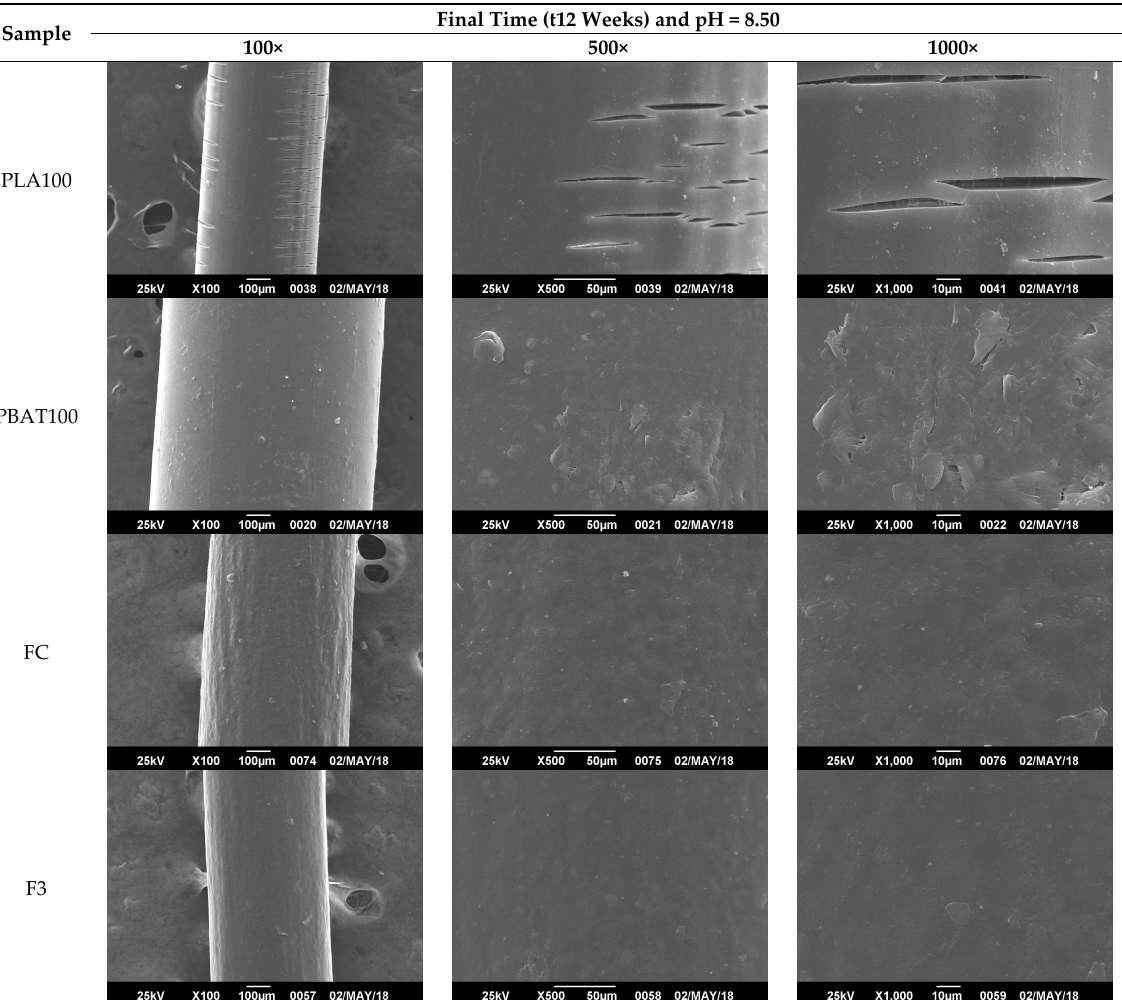
Figure 14. SEM micrographs of fibers’ surface morphology degraded for 12 weeks at pH = 8.50 and T = 25 °C.